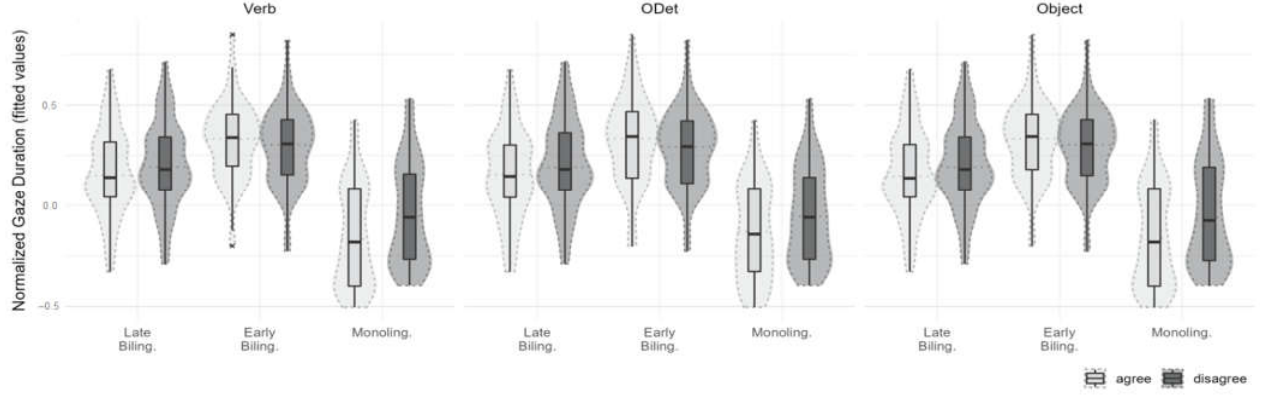
Figure 2. Normalized gaze duration means (fitted values from statistical models).